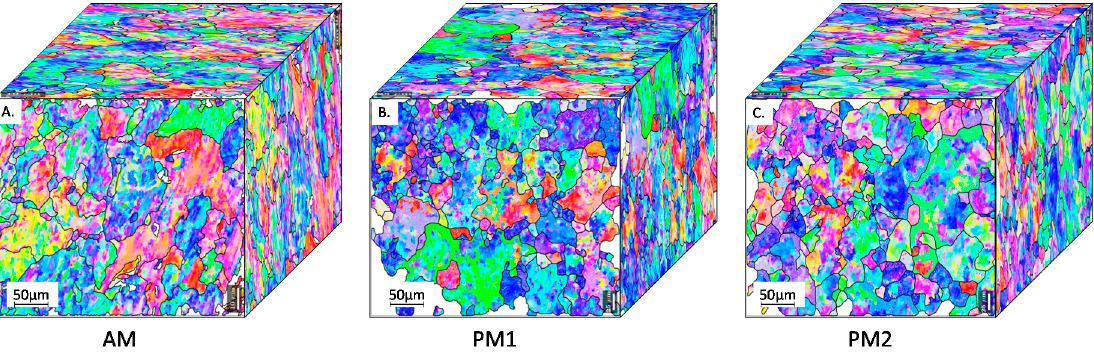
Figure 11. EBSD images of the ( A ) AM, ( B ) PM1 and ( C ) PM2 specimens. Table 4. Grain size of the AM and PM parts.